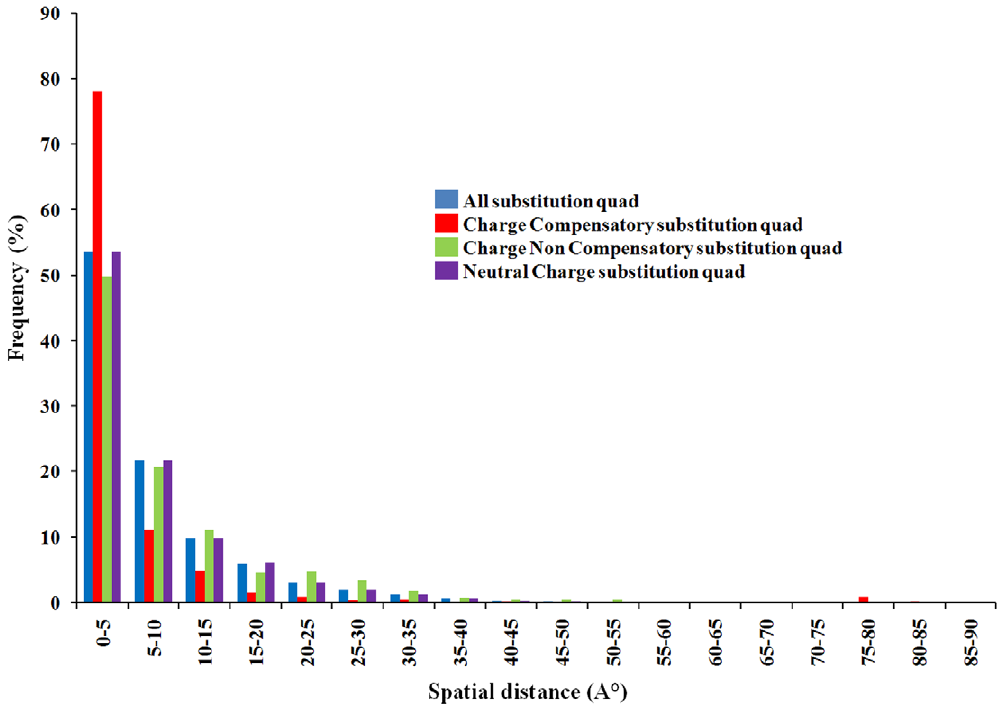
Figure 4. Charge compensatory substitutions within the coevolved sites. Frequency of charge compensatory substitutions was calculated by counting the number of charge compensatory substitution quads (see Methods for details) for each pair of coevolved alignment columns. Frequency of charge compensatory substitutions (Y axis) is plotted against the spatial distances (X axis) between coevolved residue pairs.